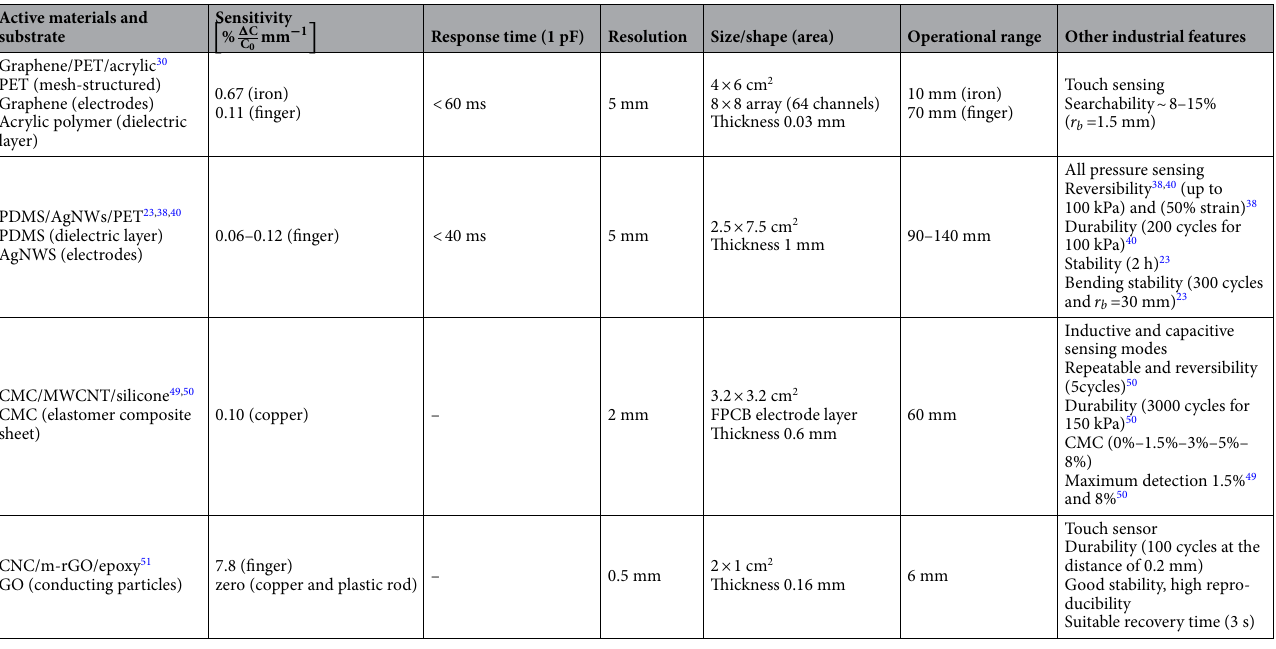
Table 1. Review of main characteristics of flexible capacitance-type proximity sensors reinforced by nanomaterials. PET: Ultrathin Polyethylene Terephthalate, FPCB: flexible printed circuit board, CNC: cellulose